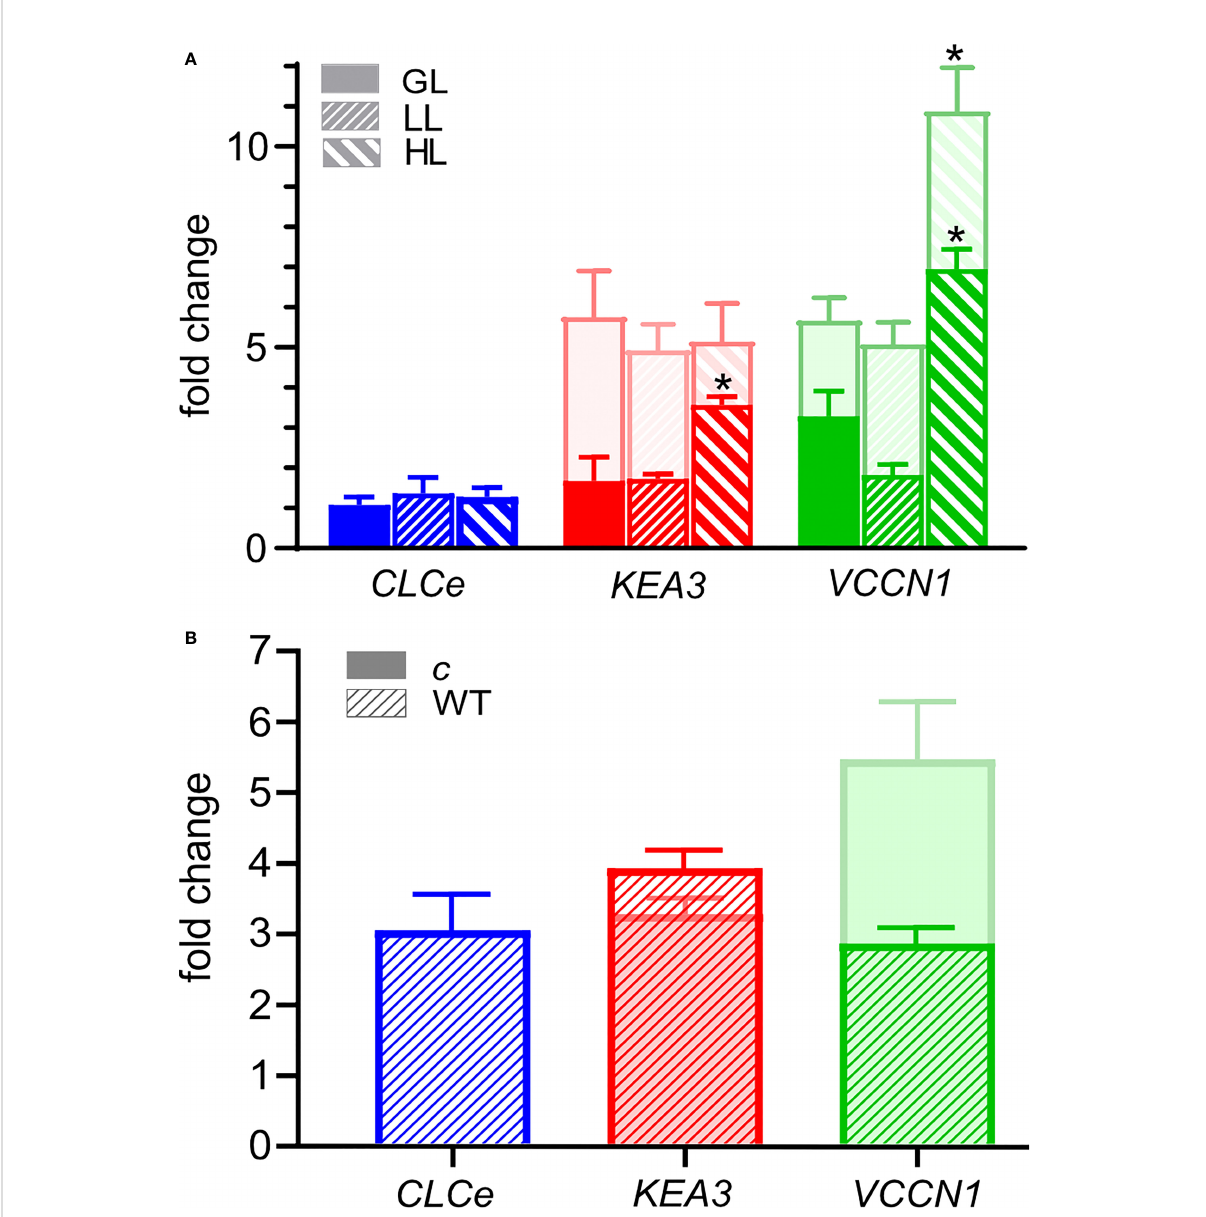
FIGURE 6 Fold change in the expression of CLCe , KEA3 and VCCN1 genes. (A) Wild type plants (WT, front bars) and clce mutants ( bars behind, lighter color) were grown in short-day conditions with 8 h light (120 µmol photons m − 2 s − 1 )/16 h dark for 6 weeks. Total RNA was isolated after 16-h dark and 3 h exposure to low light (LL, 15 µmol photons m − 2 s − 1 ), growth light (GL, 120 µmol photons m − 2 s − 1 ) or high light (HL, 650 µmol photons m − 2 s − 1 ), and changes in transcript abundance were determined by quantitative RT-PCR analysis. The expression of CLCe, KEA3 and VCCN1 genes was calculated relative to two reference genes and normalized to expression in samples collected after the 16-h of dark period. Data are the means ± S.E.M. ( n = 4). Asterisks denote a statistically signi fi cant difference between each of the light treatments and the dark control according to Student ’ s t -test ( P < 0.05). (B) WT and clce plants were grown in short-day LL condition (15 µmol photons m − 2 s − 1 ) for 8 months. Total RNA was isolated after 16-h dark and 3 h exposure to LL and changes in transcript abundance were determined by quantitative RT-PCR analysis. The relative expression of CLCe, KEA3 and VCCN1 genes was calculated as in (A) . Data are the means ± S.E.M. ( n =